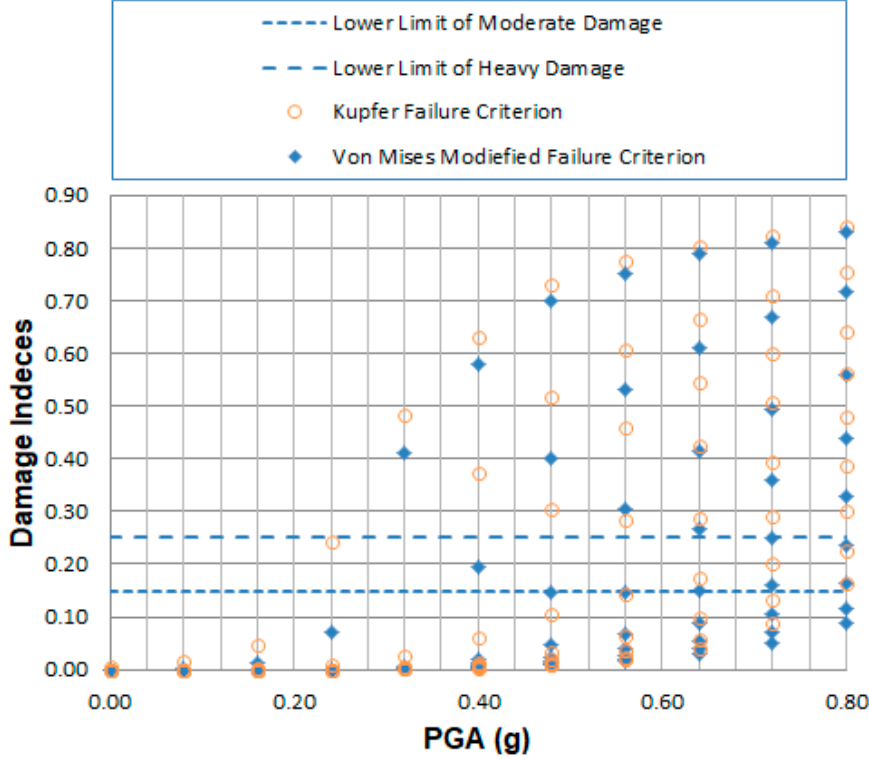
Figure 40. Damage Indices of 2D masonry wall L100H100 (Figure 36b) for opening percentages 0% and, two different failure criteria.